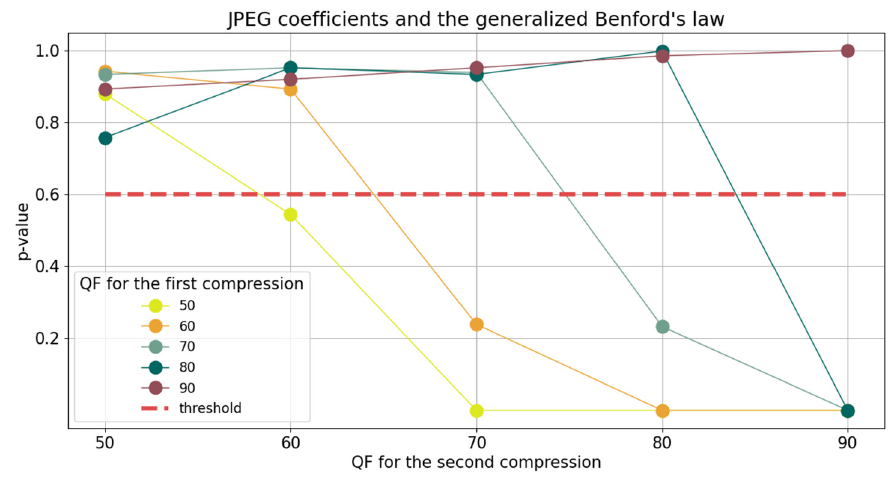
Figure 17. The JPEG coefficients compared to the GBL, using the B channel.